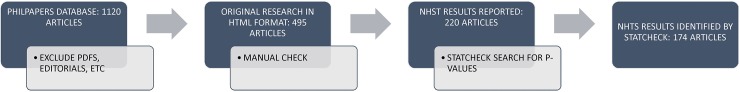
A schematic representation of our sampling procedure.